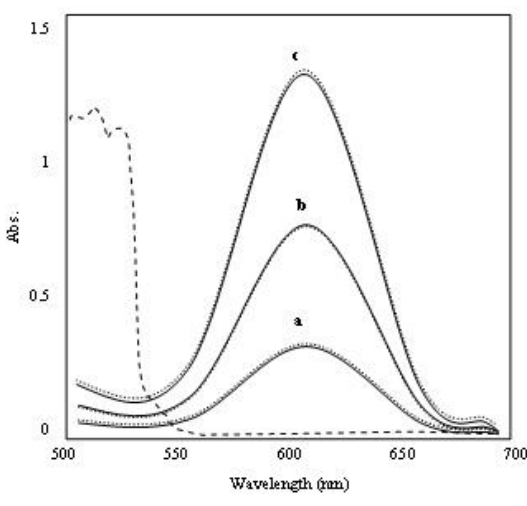
Fig. 1 Color stability of DCPIP: a, b and c were 3, 6 and 9 ppm over the time after the preparation immediately (solid curves), 2 hours later (dot curves) and in presence of CN − and Co 2+ (dashed curve), respectively.